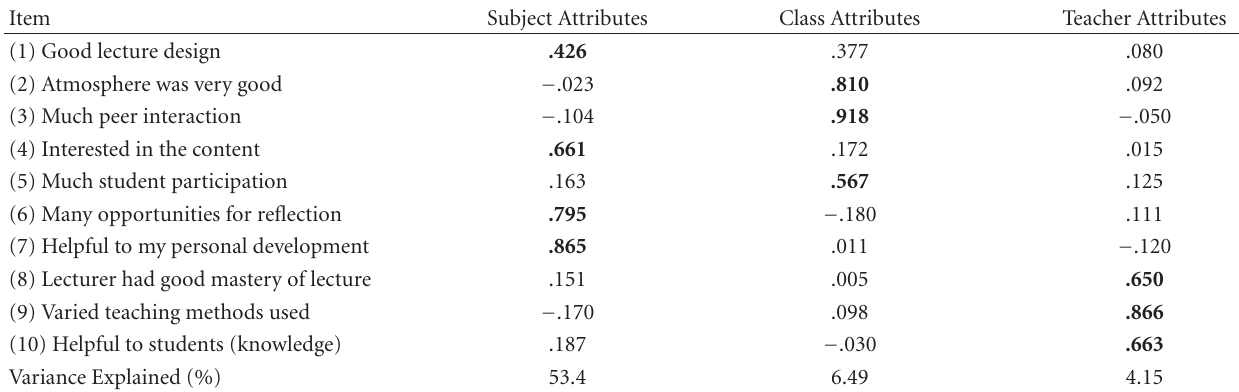
Table 3: Pattern matrix for the 10 specific items on di ff erent aspects of the